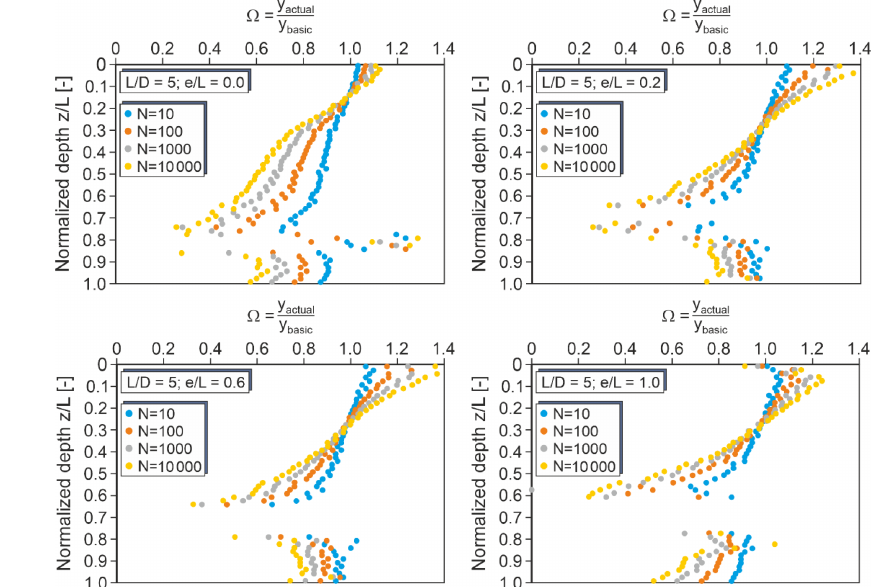
Figure 10. Correction factors (cid:127) for monopiles with L/D = 5 and different load eccentricities (very dense